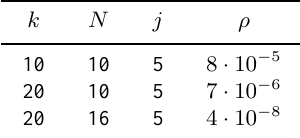
Table 11. Example 3 ( b = 20